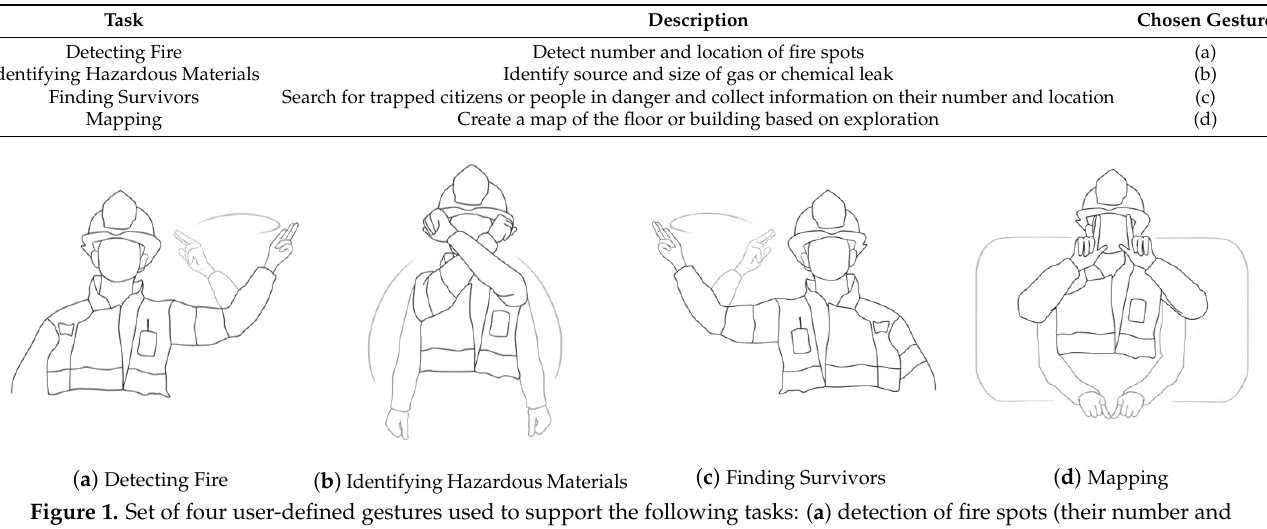
Table 1. Drone tasks used as referents for the elicitation study. The corresponding user-defined gestures are presented in Figure 1.